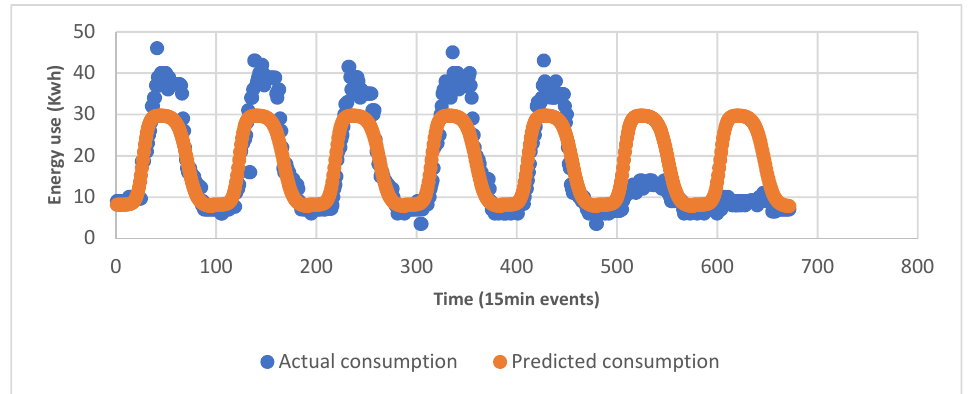
Figure A8. The first ANN predicted week of autumn.